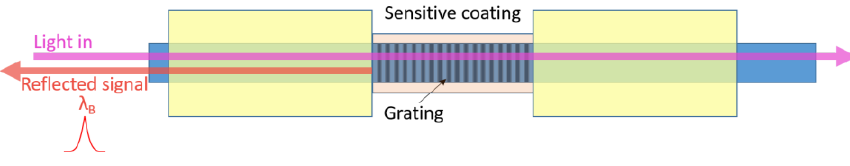
Figure 8. Schematic representation of an eFBG coated with a sensitive thin film.